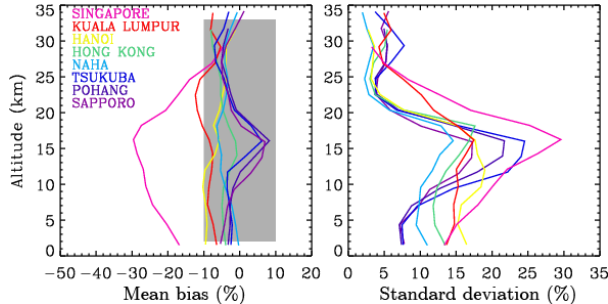
Figure 7. Mean biases and 1 σ standard deviations of the differences between ozonesonde convolved with GEMS averaging kernels and GEMS-simulated ozone retrievals as a function of GEMS layers, at individual ECC ozonesonde stations. The relative difference is defined as (Sonde AK–GEMS) × 100%/(a priori), where AK indi- cates averaging